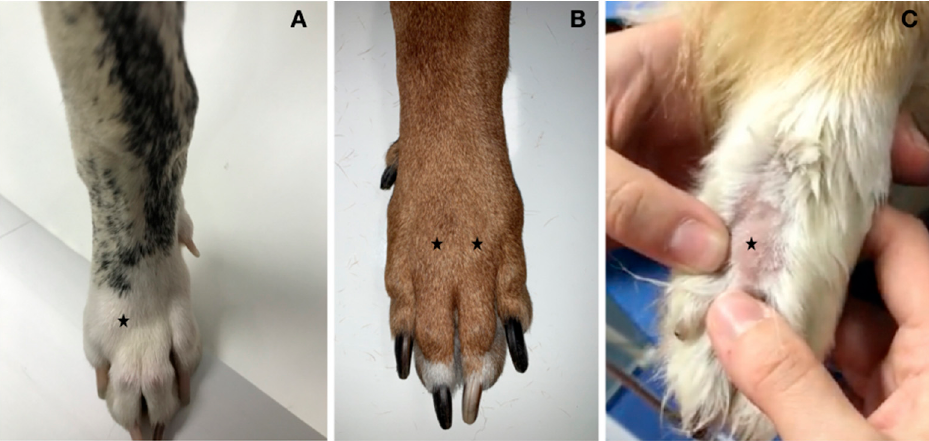
Figure 1. The appearance of the paws of cases 1, 2, and 3. ( A ) Case 1 showed clear swelling of the dorsal aspect of the forepaw, in correspondence with the MCP joint of digit IV (black star). ( B ) Case 2 showed mild swelling of the dorsal aspect of the forepaw, in correspondence with the MCP joint of digits III and IV (black star). ( C ) Case 3 showed mild swelling of the dorsal aspect of the forepaw, in correspondence with the MCP joint of digit IV (black star).